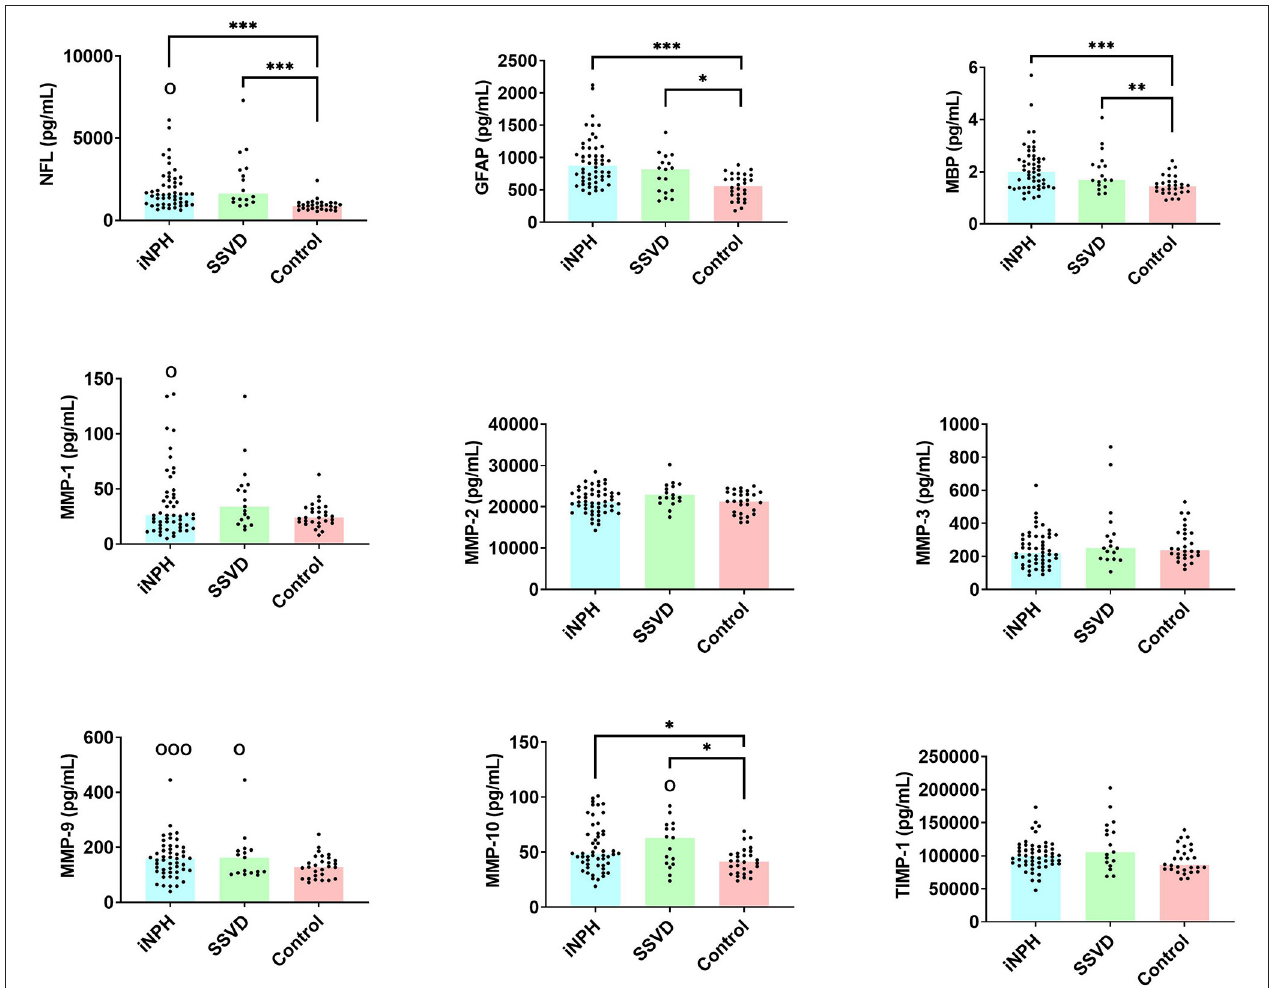
FIGURE 2 | Cerebrospinal fluid (CSF) biomarkers of white matter damage, astroglial response, and extracellular matrix remodeling in 52 patients with iNPH, 17 with SSVD, and 28 controls. Concentration is plotted as individual values. Bars indicate median values. Only significant values are marked. iNPH, idiopathic normal pressure hydrocephalus; SSVD, subcortical small vessel disease; NFL, Neurofilament light protein; GFAP, glial fibrillary acidic protein; MBP, myelin basic protein; MMP, matrix metalloproteinases; TIMP, tissue inhibitors of metalloproteinases. O indicates values outside the